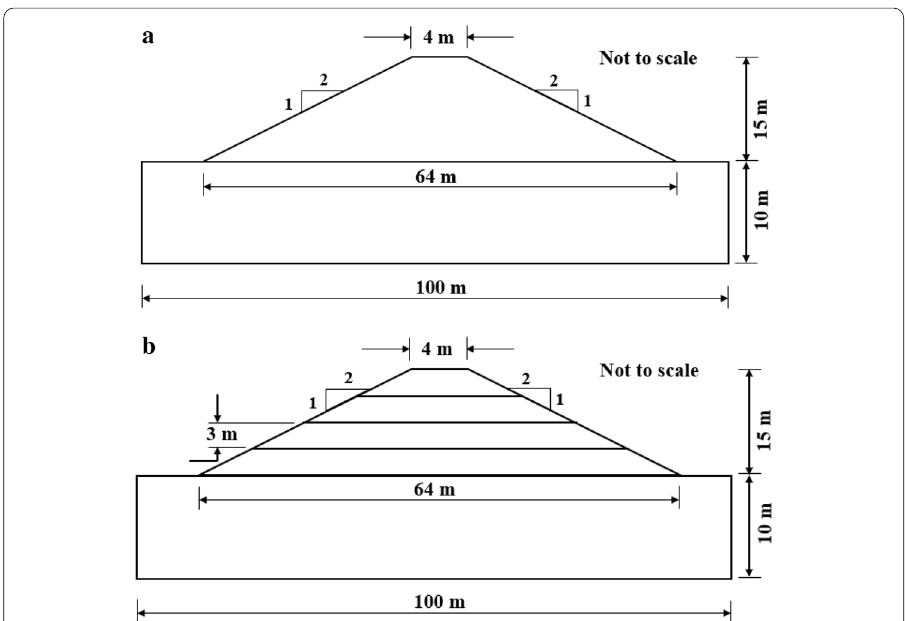
Fig. 5 Numerical models of earthen dam constructed in a simplified single lift b real-field multiple lifts